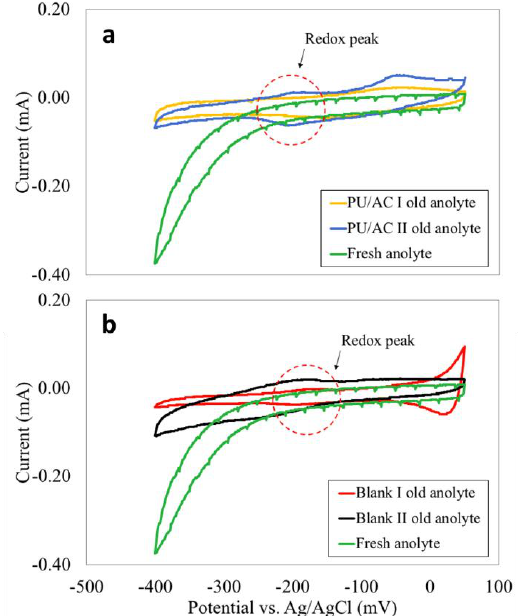
Figure 9. ( a ) Ex situ CVs in old and fresh anolyte from PU/AC I and PU/AC II. ( b ) Ex-situ CVs in old and fresh anolyte from Blank I and Blank II. 3.3. Diverse Microbial Community both in the Bioanode and Bioanolyte Predominantly by Proteobacteria